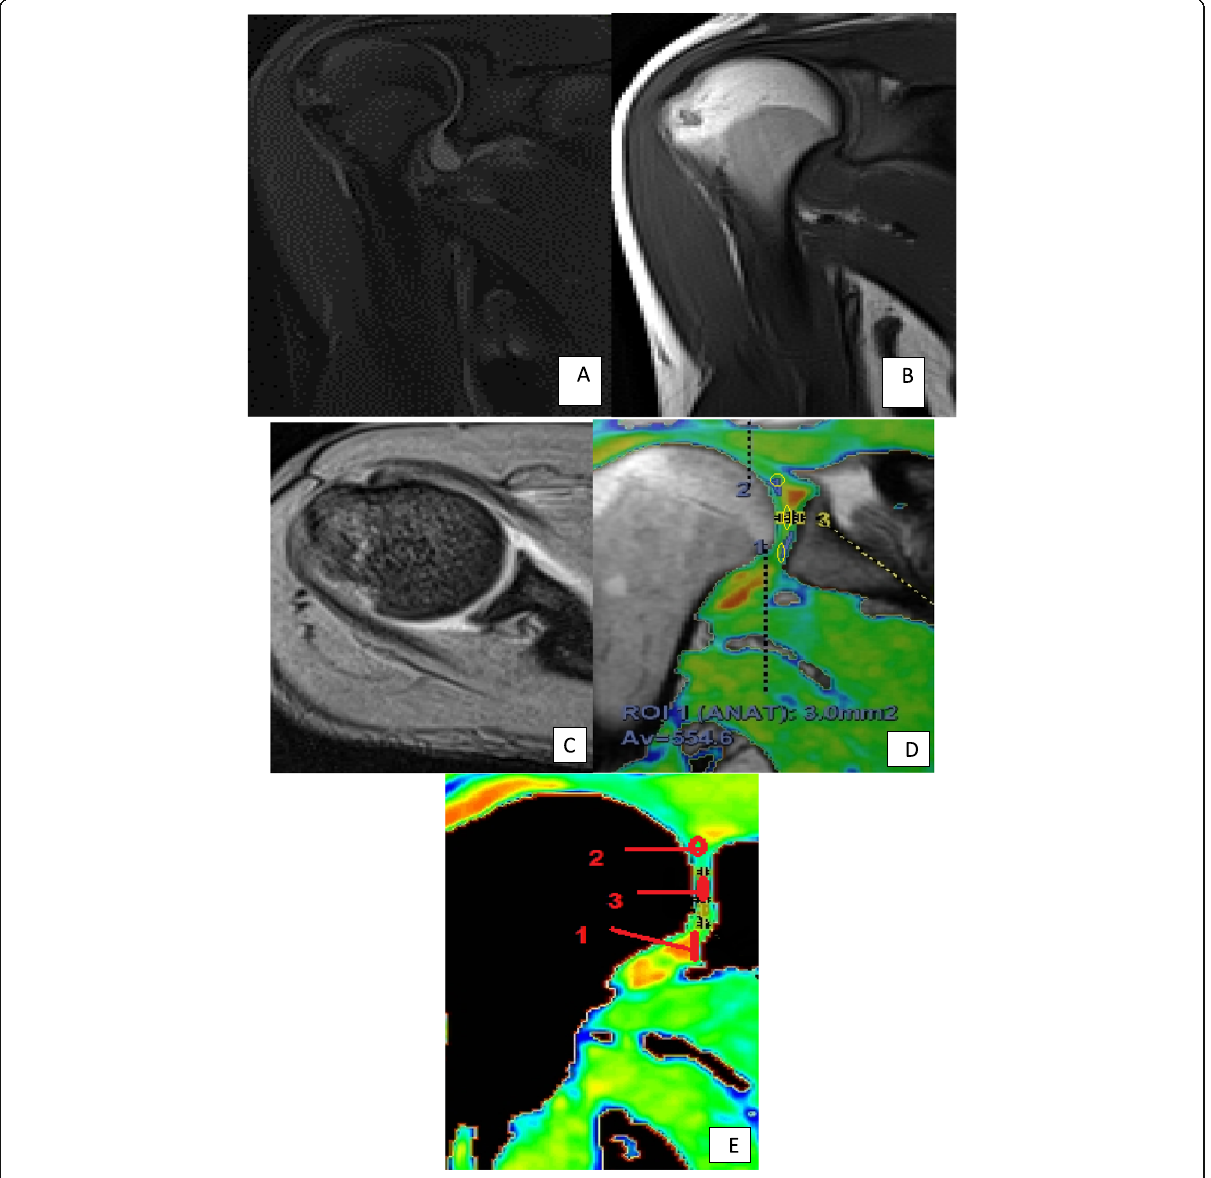
Fig. 4 a Coronal T1 WI. b Coronal proton density (PD )WI. c An axial T2WI showed a very mild osteoarthritic change in the form of minimal osteophytes (grade I). c T2 mapping. d Processed image showed T2 values, 55.52 ms, 53.9 ms, and 65 ms for glenoid zone (1), mid zone (3), and humeral zone (2) respectively(red